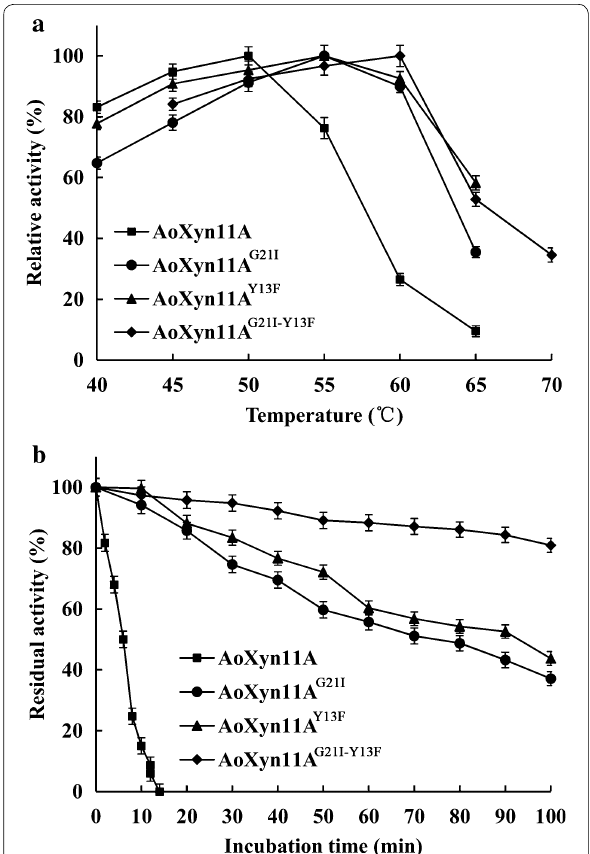
Fig. 5 The temperature characteristics of four recombinant xylanases. a The T opt of xylanase was measured, at pH optimum, at tempera‑ tures ranging from 40 to 70 °C. b The t 50 1/2 of xylanase was assayed by incubated it at 50 °C for different